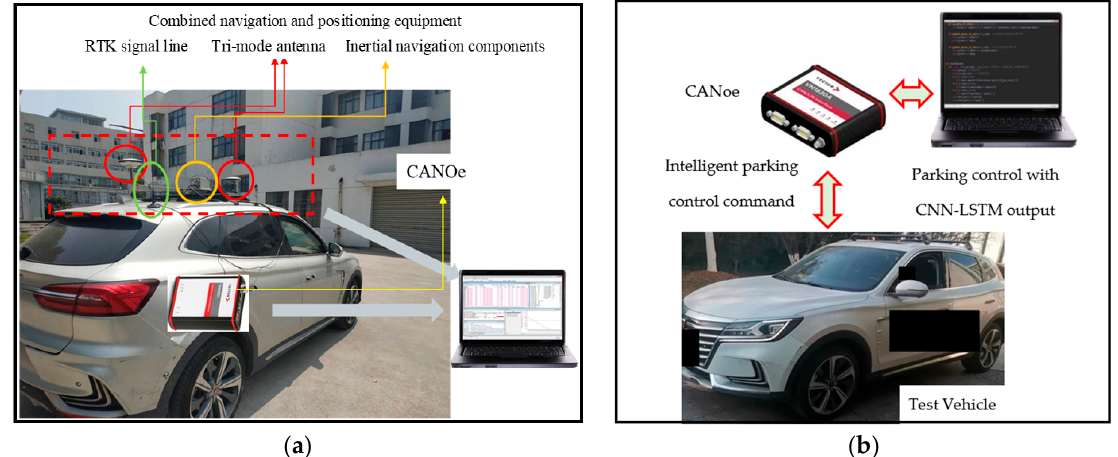
Figure 15. Actual parallel parking slot: ( a ) Vehicle obstacle, columnar obstacle, and curbstone obsta- cles; ( b ) columnar obstacle and curbstone obstacles; ( c ) vehicle obstacle and curbstone obstacles; ( d ) vehicle obstacle and fuzzy parking slot line; ( e ) vehicle obstacle and columnar obstacle and fuzzy parking slot line; and ( f ) vehicle obstacle and covered parking slot lines.